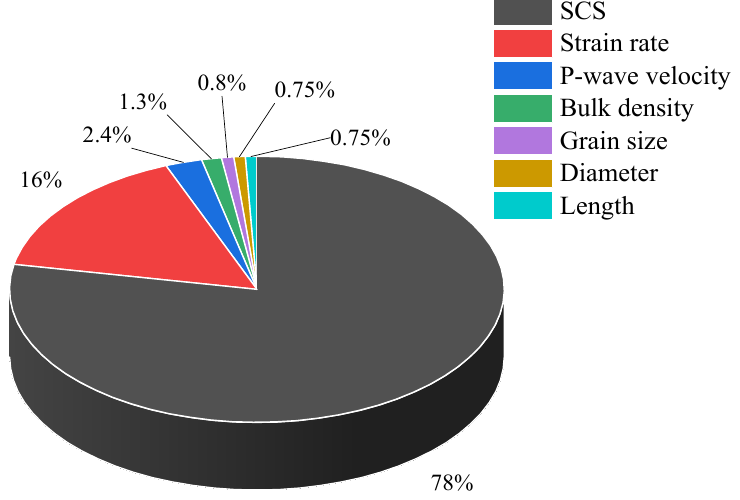
Figure 7. Three-dimensional pie chart of the relative importance of parameters to output.